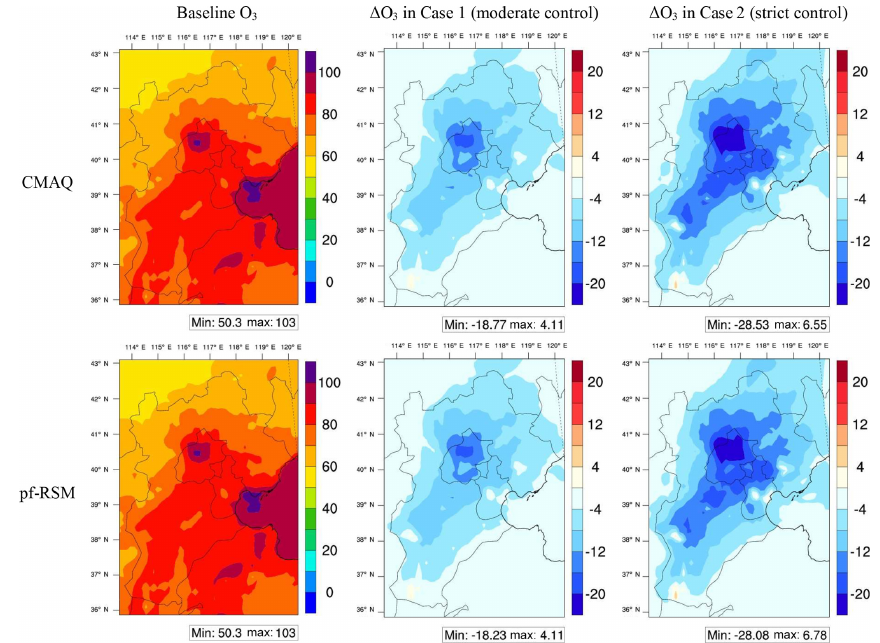
Figure 8. Spatial distribution of CMAQ-simulated and pf-RSM-predicted O 3 in baseline and O 3 responses in two control scenarios (monthly averages of daily 1h maxima O 3 in July 2014, unit: ppb, E NO − 64, and − 20 and − 76, − 79, − 81, − 83, and − 73%,